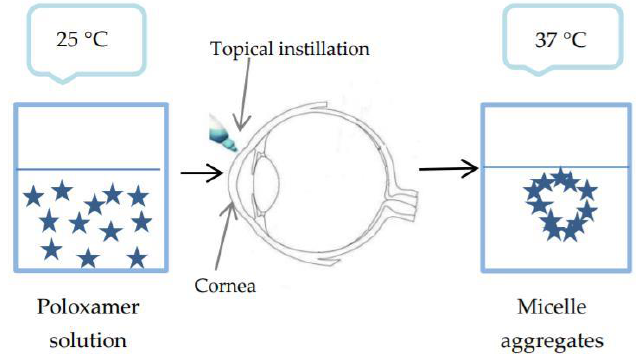
Figure 7. Sol-gel transition of poloxamer.